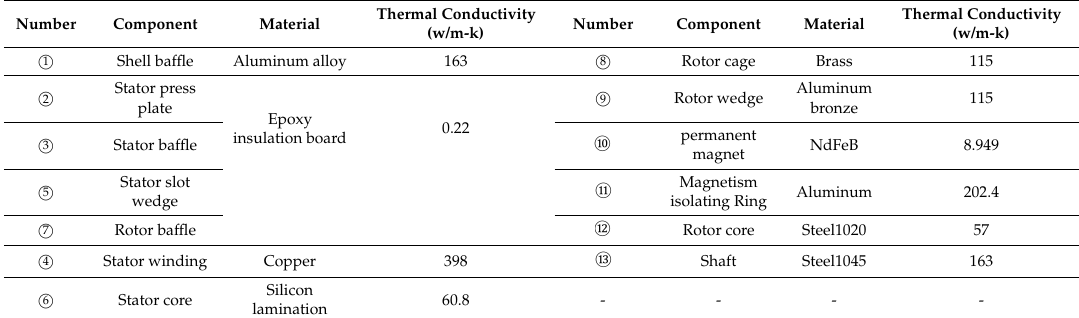
Figure 1 . Structural model of the High-Voltage Line-Start Solid Rotor Permanent Magnet Synchronous Motor (HVLSSR-PMSM). Table 2. Materials properties of each part of the motor.